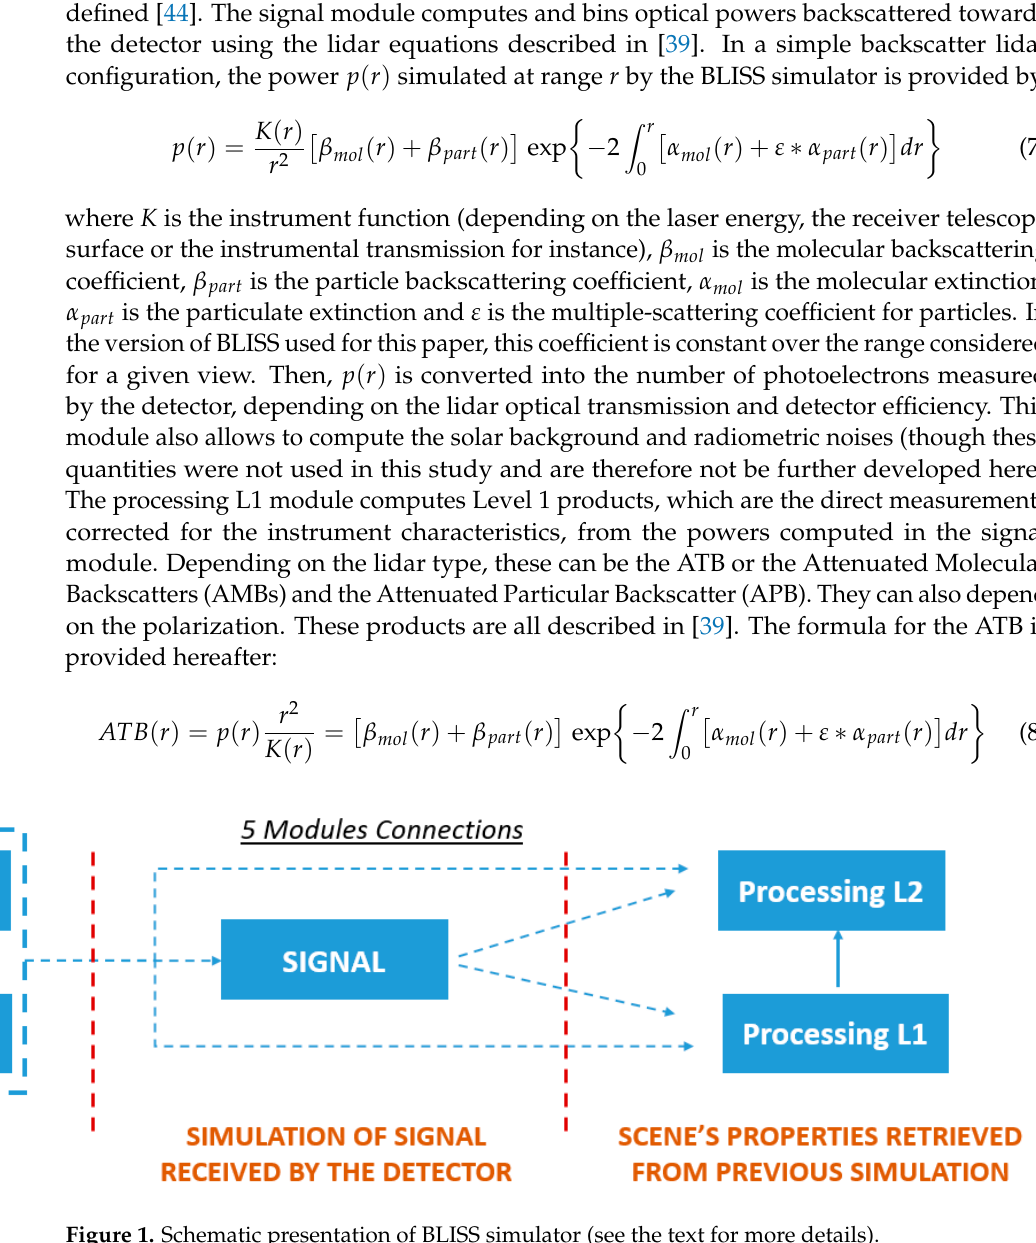
Figure 1. Schematic presentation of BLISS simulator (see the text for more details).